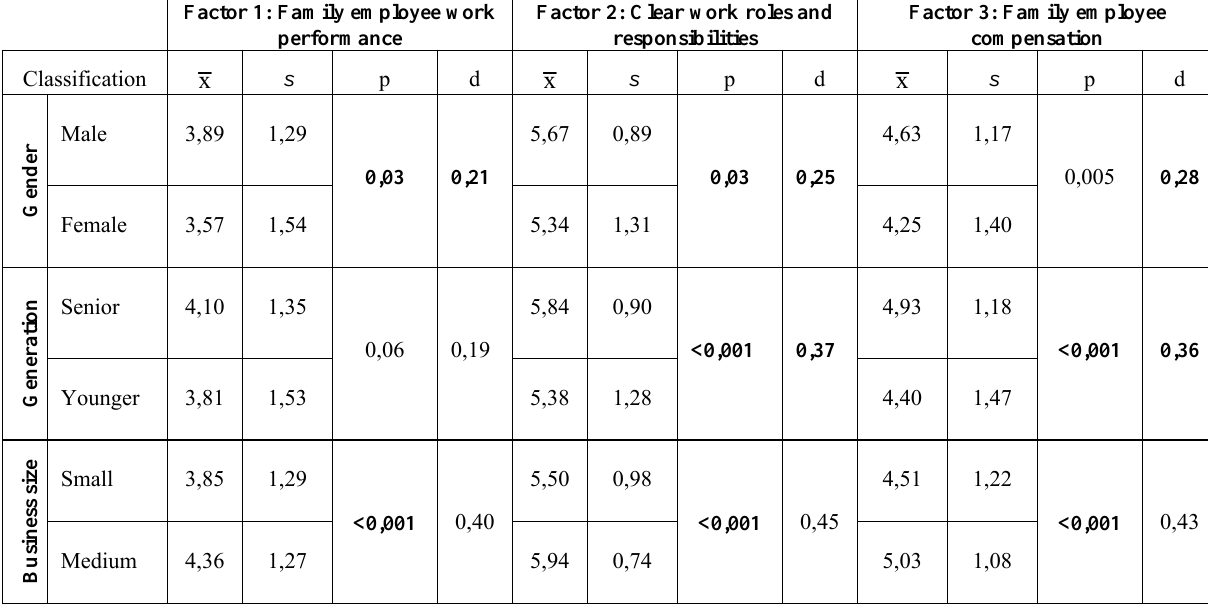
Table 5: The results of the differences in means between the constructs for different demographic variables Factor 1: Family employee work Factor 2: Clear work roles and performance